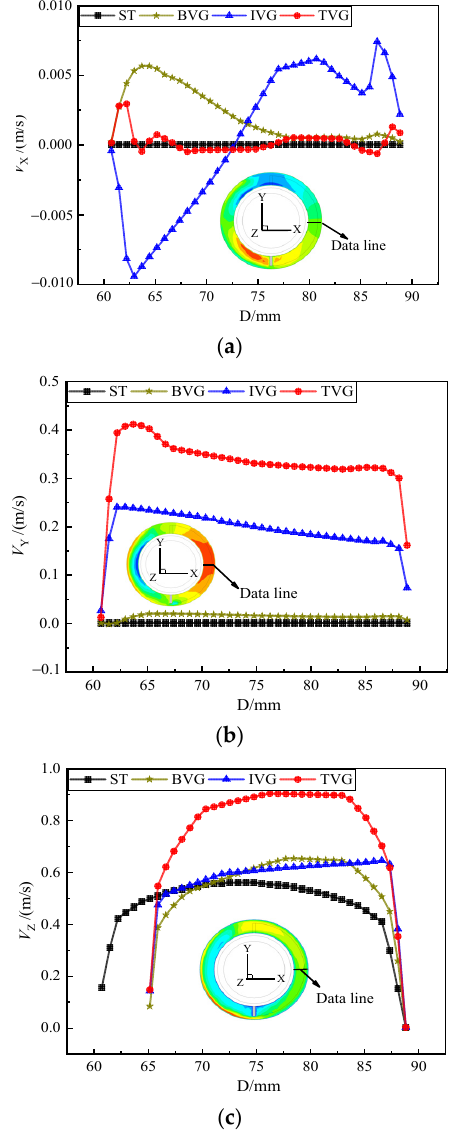
Figure 11. Velocity variation curves of fluid in the injection channel of the cross-section at the vortex generator of the different heat exchangers. ( a ) Variation curve of the velocity in the X -direction of the four heat exchangers; ( b ) variation curve of the velocity in the Y -direction of the four heat exchangers; ( c ) variation curve of the velocity in the Z -direction of the four heat exchangers.